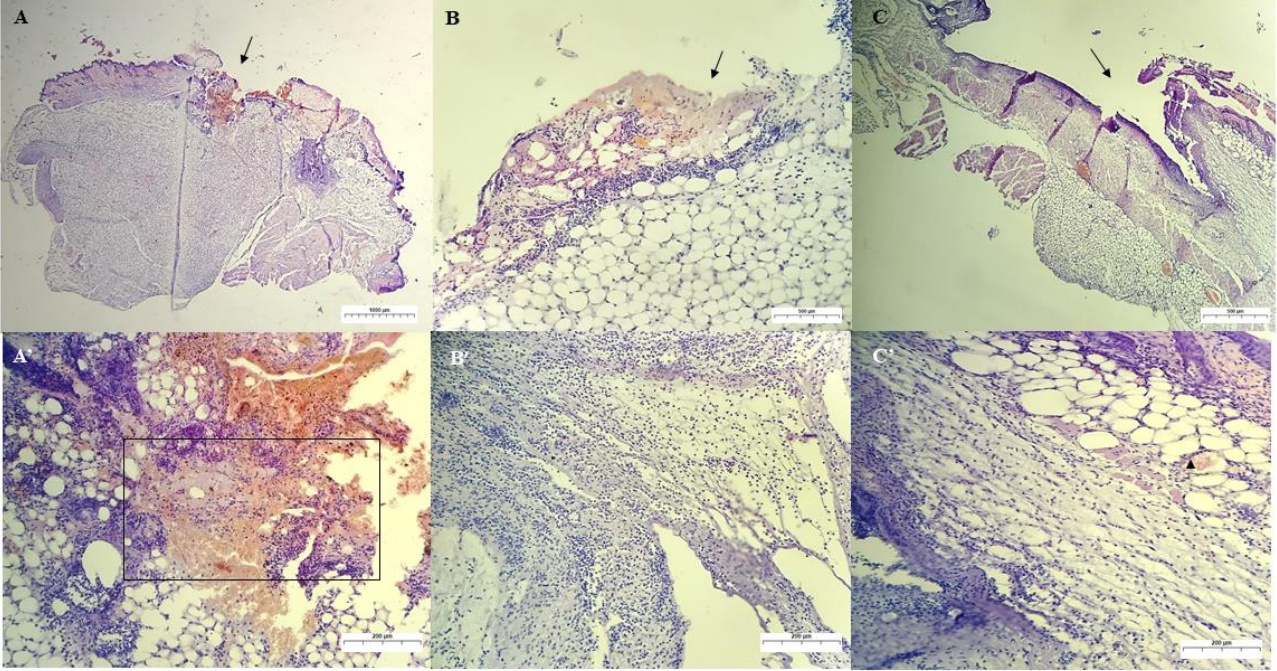
Figure 9. Photomicrograph of skin lesion in mice on the 3rd day of treatment. ( A ): Skin ulcer (arrow) treated with PS, showing in detail ( A’ ) an area of cellular debris, clot, and intense PMN inflammatory infiltrate (magnification: 20 × and 100 × , respectively). ( B ): Skin ulcer treated with GChi, showing a smaller amount of fibrin clot (arrow), and, in detail ( B’ ), an intense PMN inflammatory infiltrate through the layers of the deep dermis (magnification: 40 × and 100 × , respectively). ( C ): Cutaneous ulcer treated with GChiN2 (arrow), showing, in detail ( C’ ), ulceration with cellular debris and mixed inflammatory infiltrate (PMN and MN) more concentrated around the wound, and with moderate infiltration in the dermis and blood vessel with leukocyte exudation (arrowhead—magnification: 40 × and 100 × , respectively). Staining by H.E. physiological serum (PS), chicha hydrogel (GChi), chicha hydrogel with 0.02 g mL − 1 nerolidol (GChiN2), polymorphonuclear leukocytes (PMN), mononuclear leukocytes